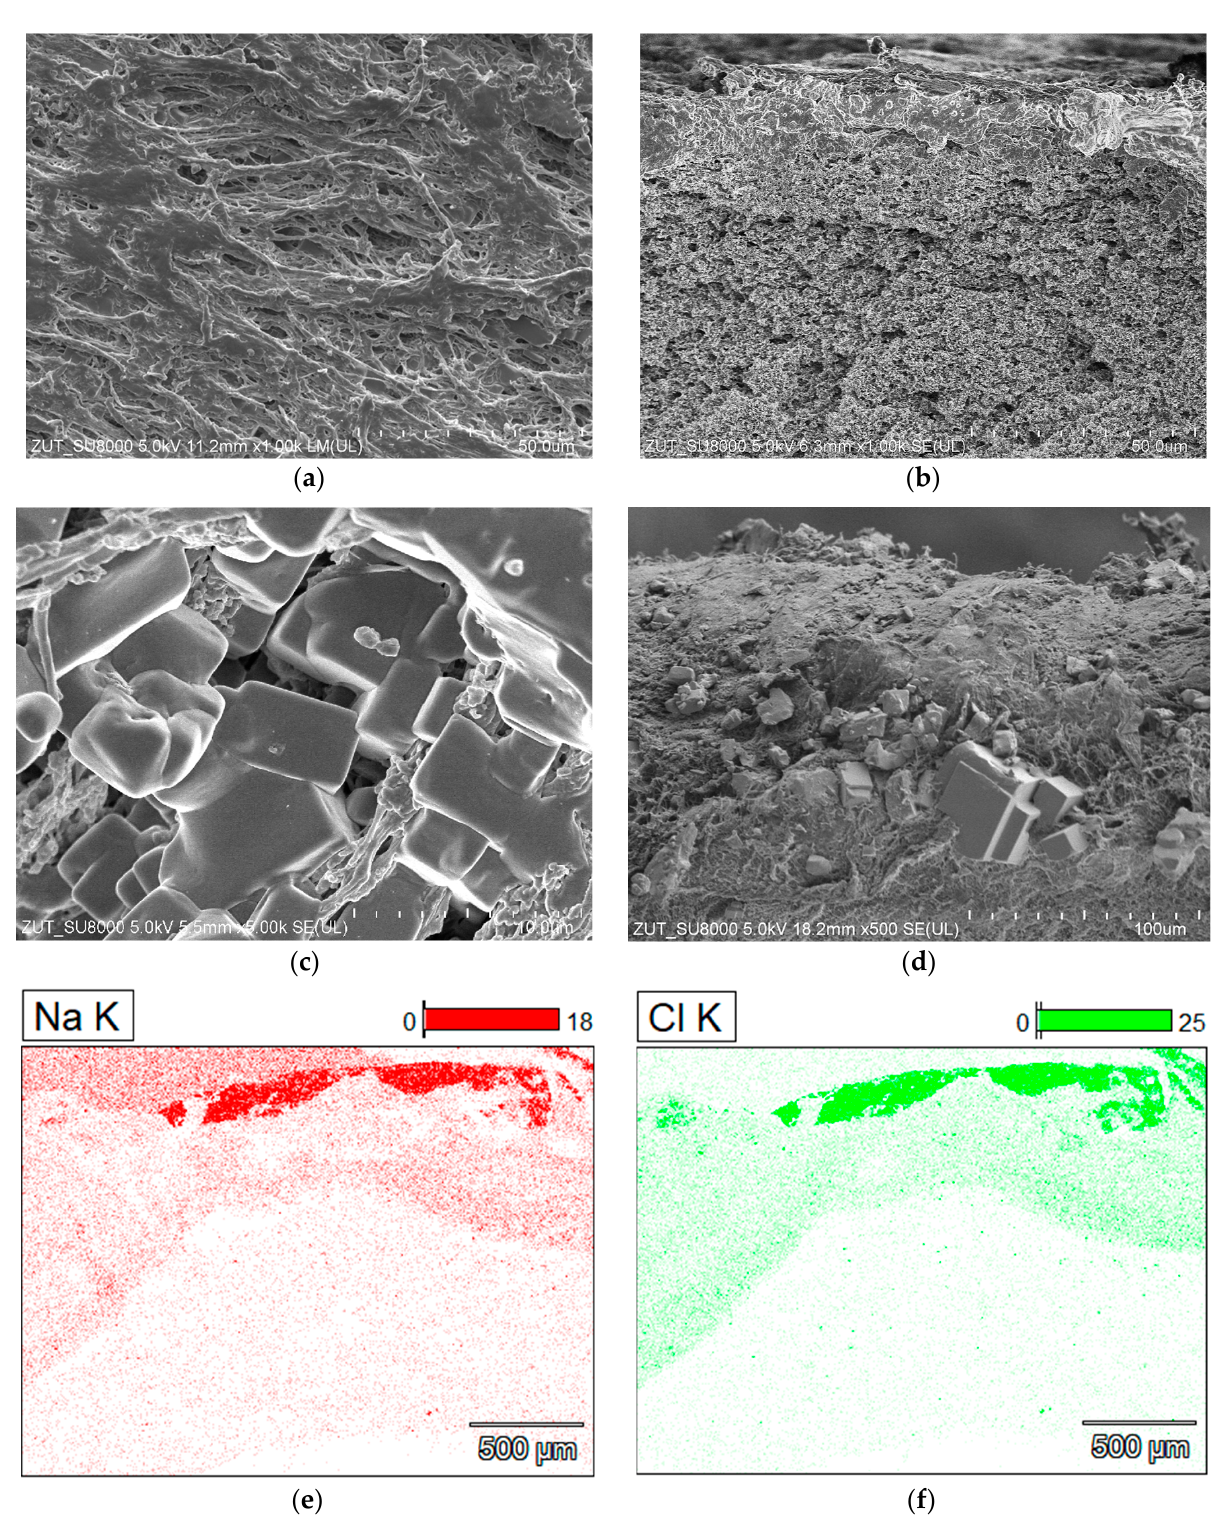
Figure 4. SEM images of new V8 membrane ( a , b ) and SEM images of membrane samples collected from M1 module after 380 h MD process of NaCl solution concentrated to supersaturated state. ( c ) NaCl crystals on the membrane surface, ( d ) membrane cross-section with NaCl crystals inside pores, and SEM-EDS analysis: ( e ) content of Na inside membrane wall, ( f ) content of Cl inside membrane wall.